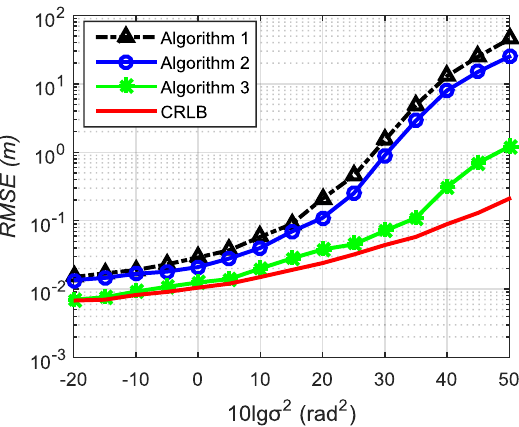
Figure 3. RMSE curve with orientation angle measurement error for different algorithms at SNR = 10 dB.